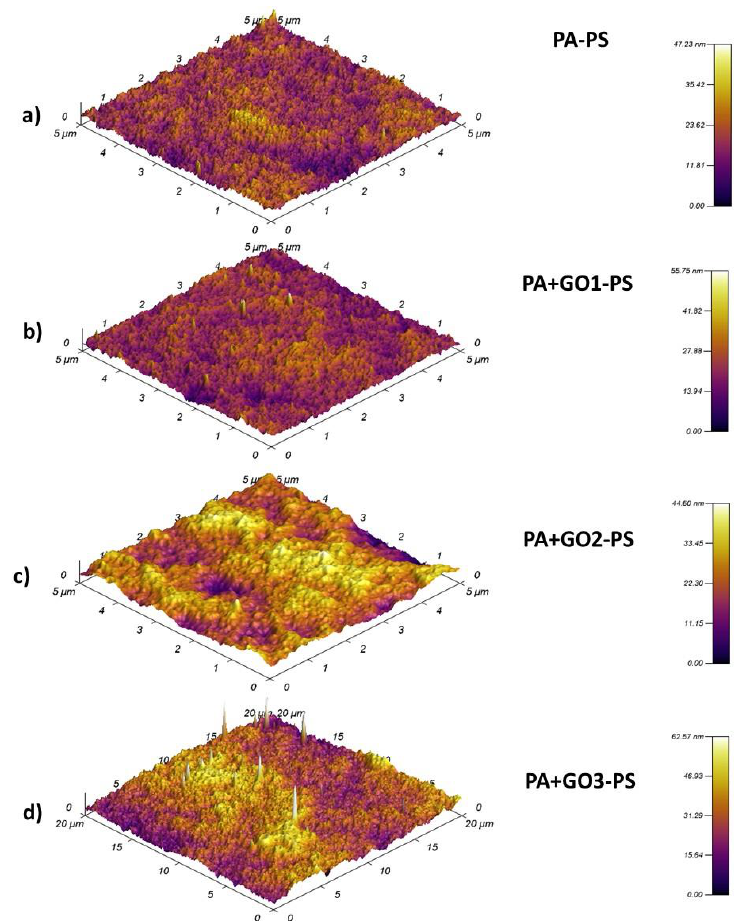
Figure 6. Atomic force microscopy (AFM) images of membranes. ( a ) PA-PS, ( b ) PA+GO1-PS, ( c ) Figure6. Atomicforcemicroscopy(AFM)imagesofmembranes. ( a )PA-PS,( b )PA + GO1-PS,( c )PA + GO2-PS, PA+GO2-PS, ( d ) PA+GO3-PS. ( d ) PA + Table 3. Surface properties of the membranes.